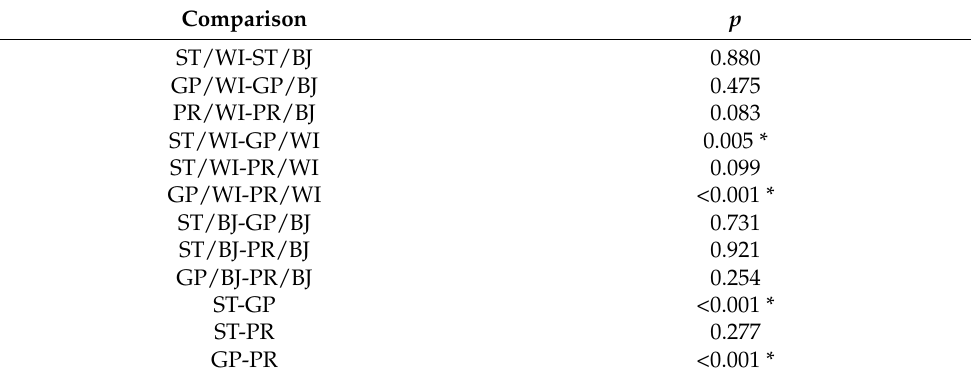
Table 4. p values of post hoc